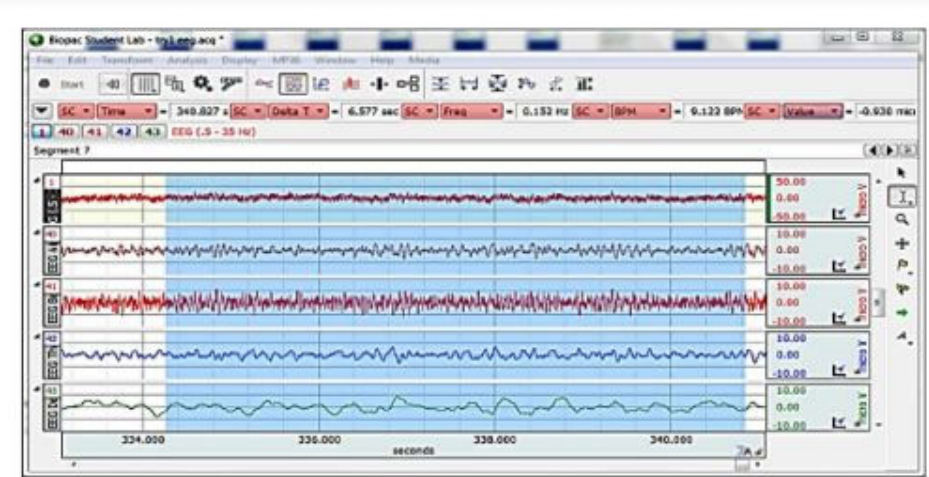
Figure 7. EEG electrode testing performance.